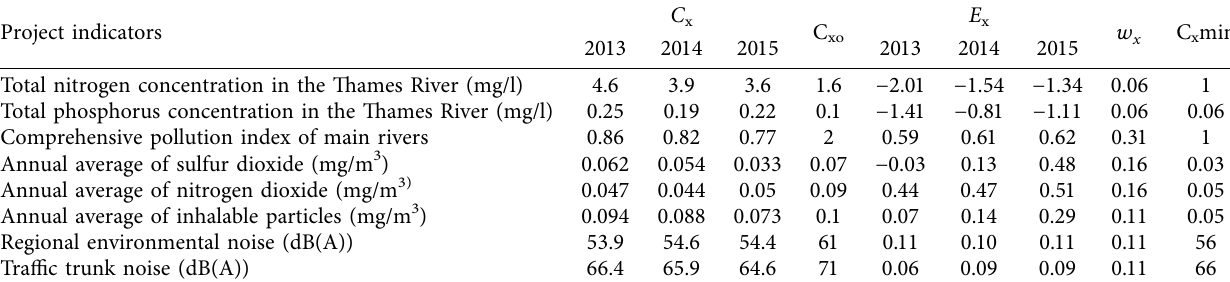
Table 3: Single-factor ecocultural bearing capacity of eight indicators of London urban agglomeration [12]. Project indicators